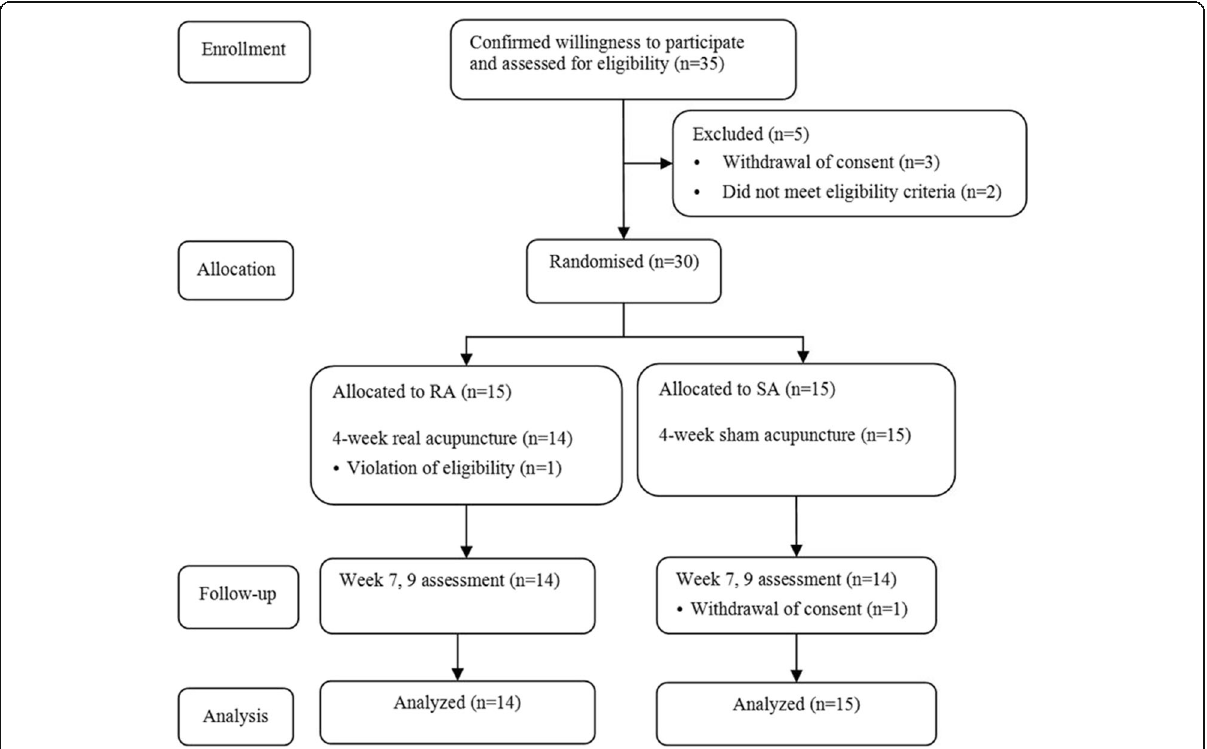
Fig. 1 CONSORT flow chart of the study. RA, real acupuncture; SA, sham